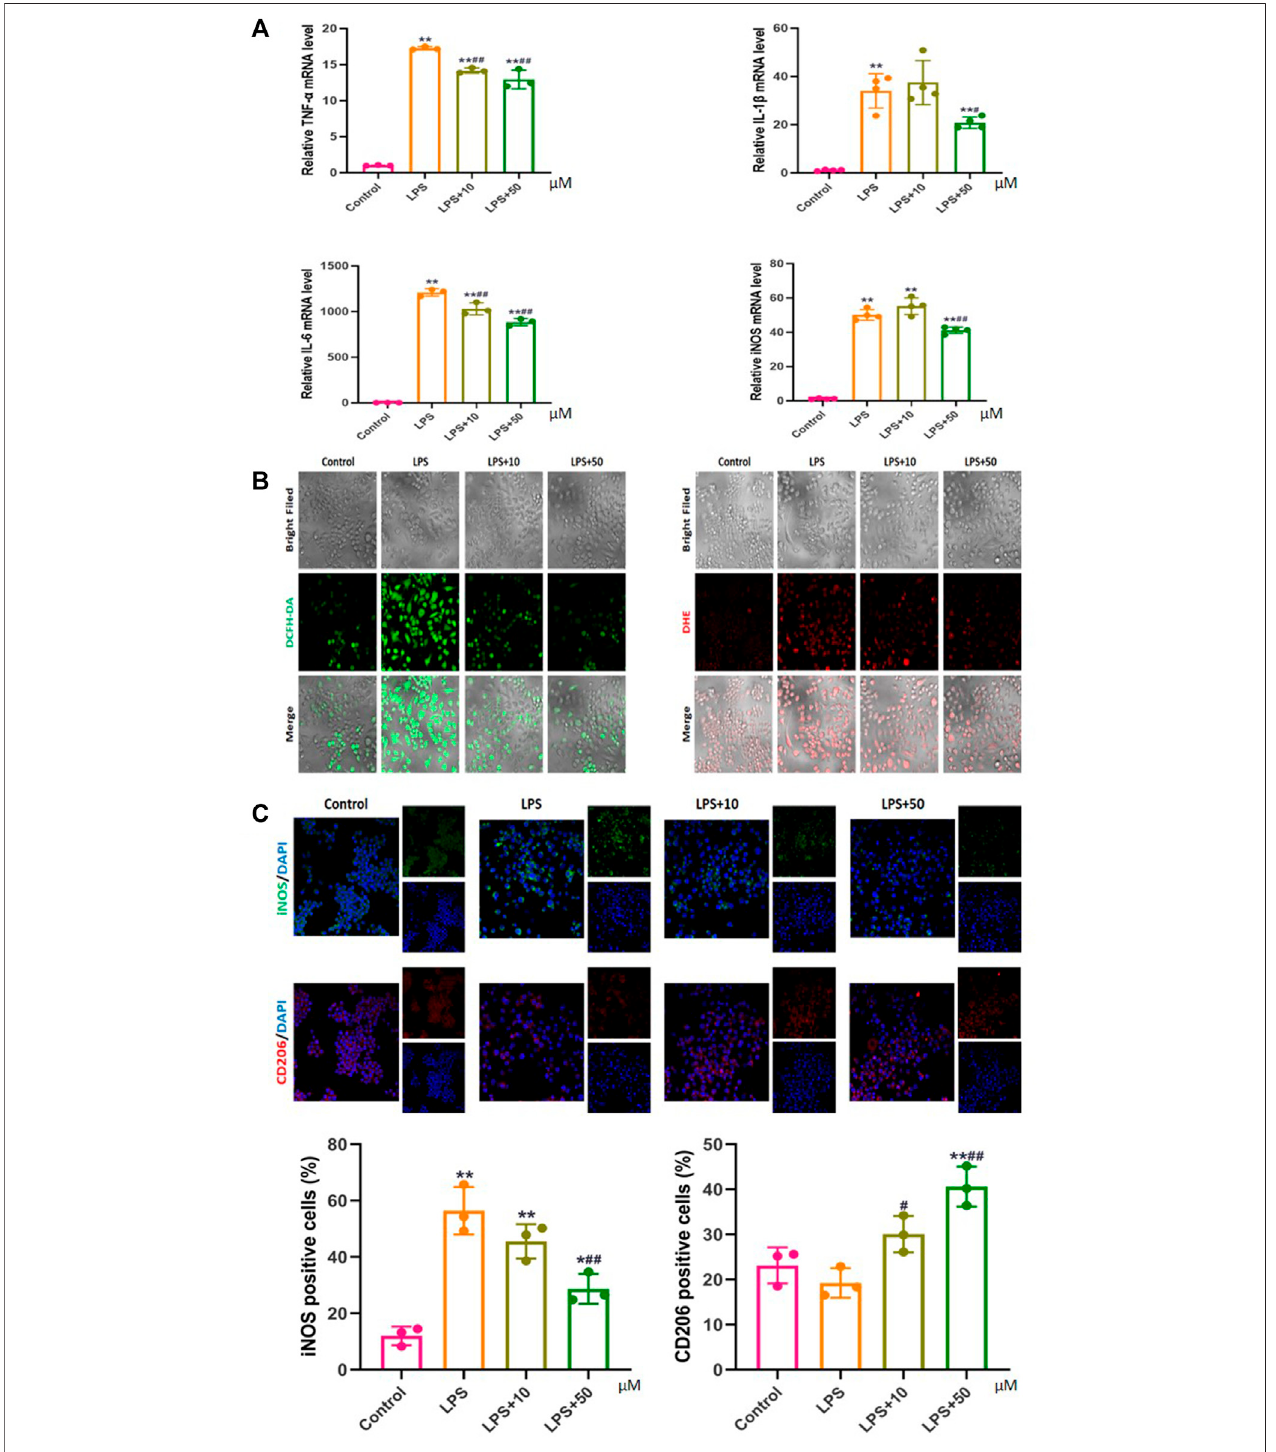
FIGURE3| Effect ofPAPonin fl ammationand oxidative stress (A) Real-time PCRofpro-in fl ammatorygenes (B) Detection ofreactive oxygen species (ROS) using DCFH-DA and DHE probes (C) Immuno fl uorescence to detect markers of macrophage polarization. *p < 0.05, ** p < 0.01 compared with the control group; # p < 0.05, ## p < 0.01 compared with the LPS group.